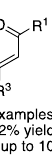
Figure 39. Meyer-Schuster rearrangement of propargylic alcohols.